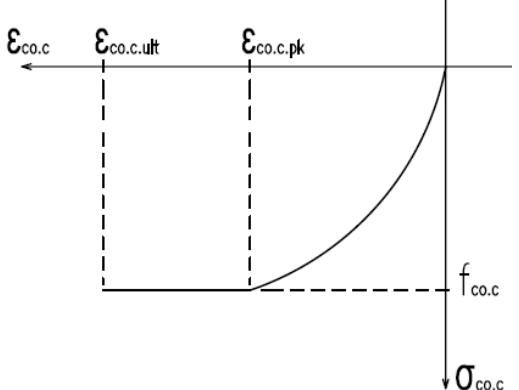
Figure 2. Stress–strain diagram for concrete under compression.